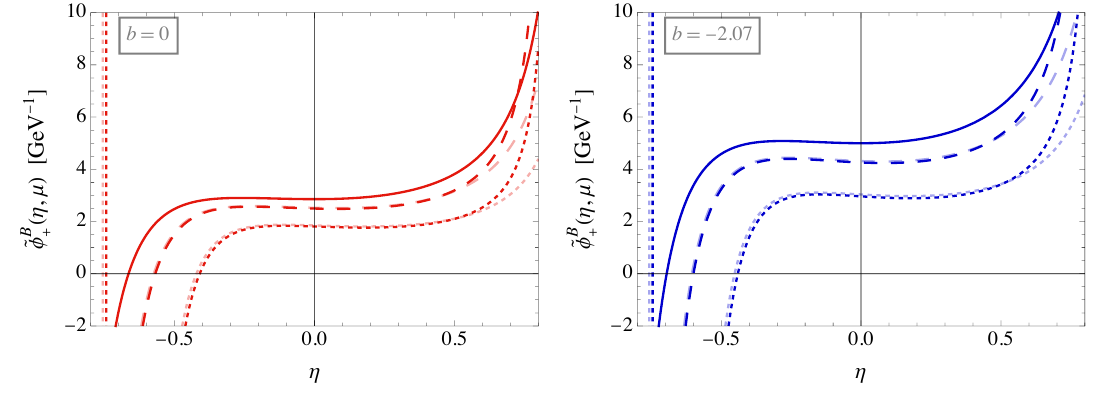
Figure 3 . Scale evolution of the model functions for the LCDA in Laplace space with ω 0 = 482 MeV and b = 0 (left), b = − 2 . 07 (right). The solid lines show the results at µ = µ s = 1 GeV, the dashed lines correspond to µ = 1 . 5 GeV, and the dotted lines refer to the scale of the b -quark pole mass, µ = m b = 4 . 8